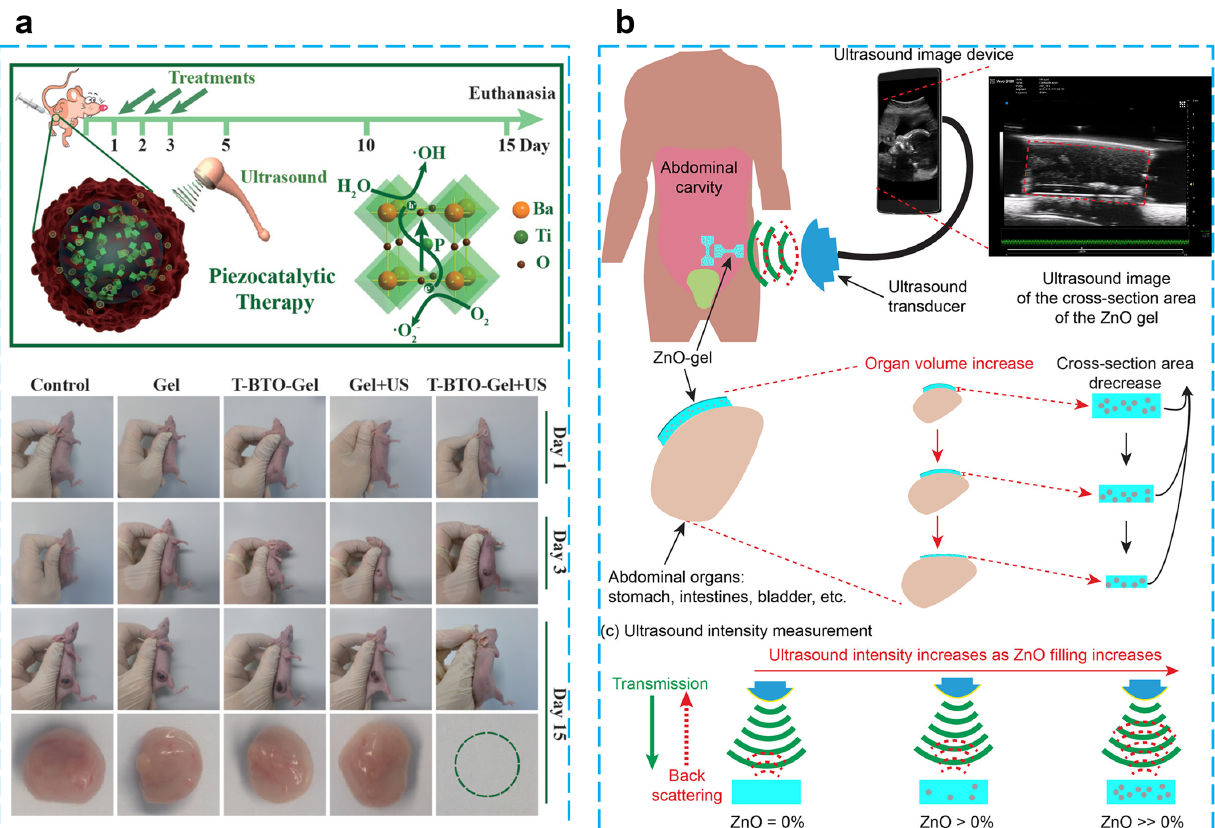
Figure 7. ( a ) Piezocatalytic tumor therapy by ultrasound-triggered and BaTiO 3 -mediated piezoelectricity. (Reprinted with permission from Ref. [98], Copyright 2020, WILEY-VCH Verlag GmbH & Co.) ( b ) A wireless implantable strain-sensing scheme using ultrasound imaging of